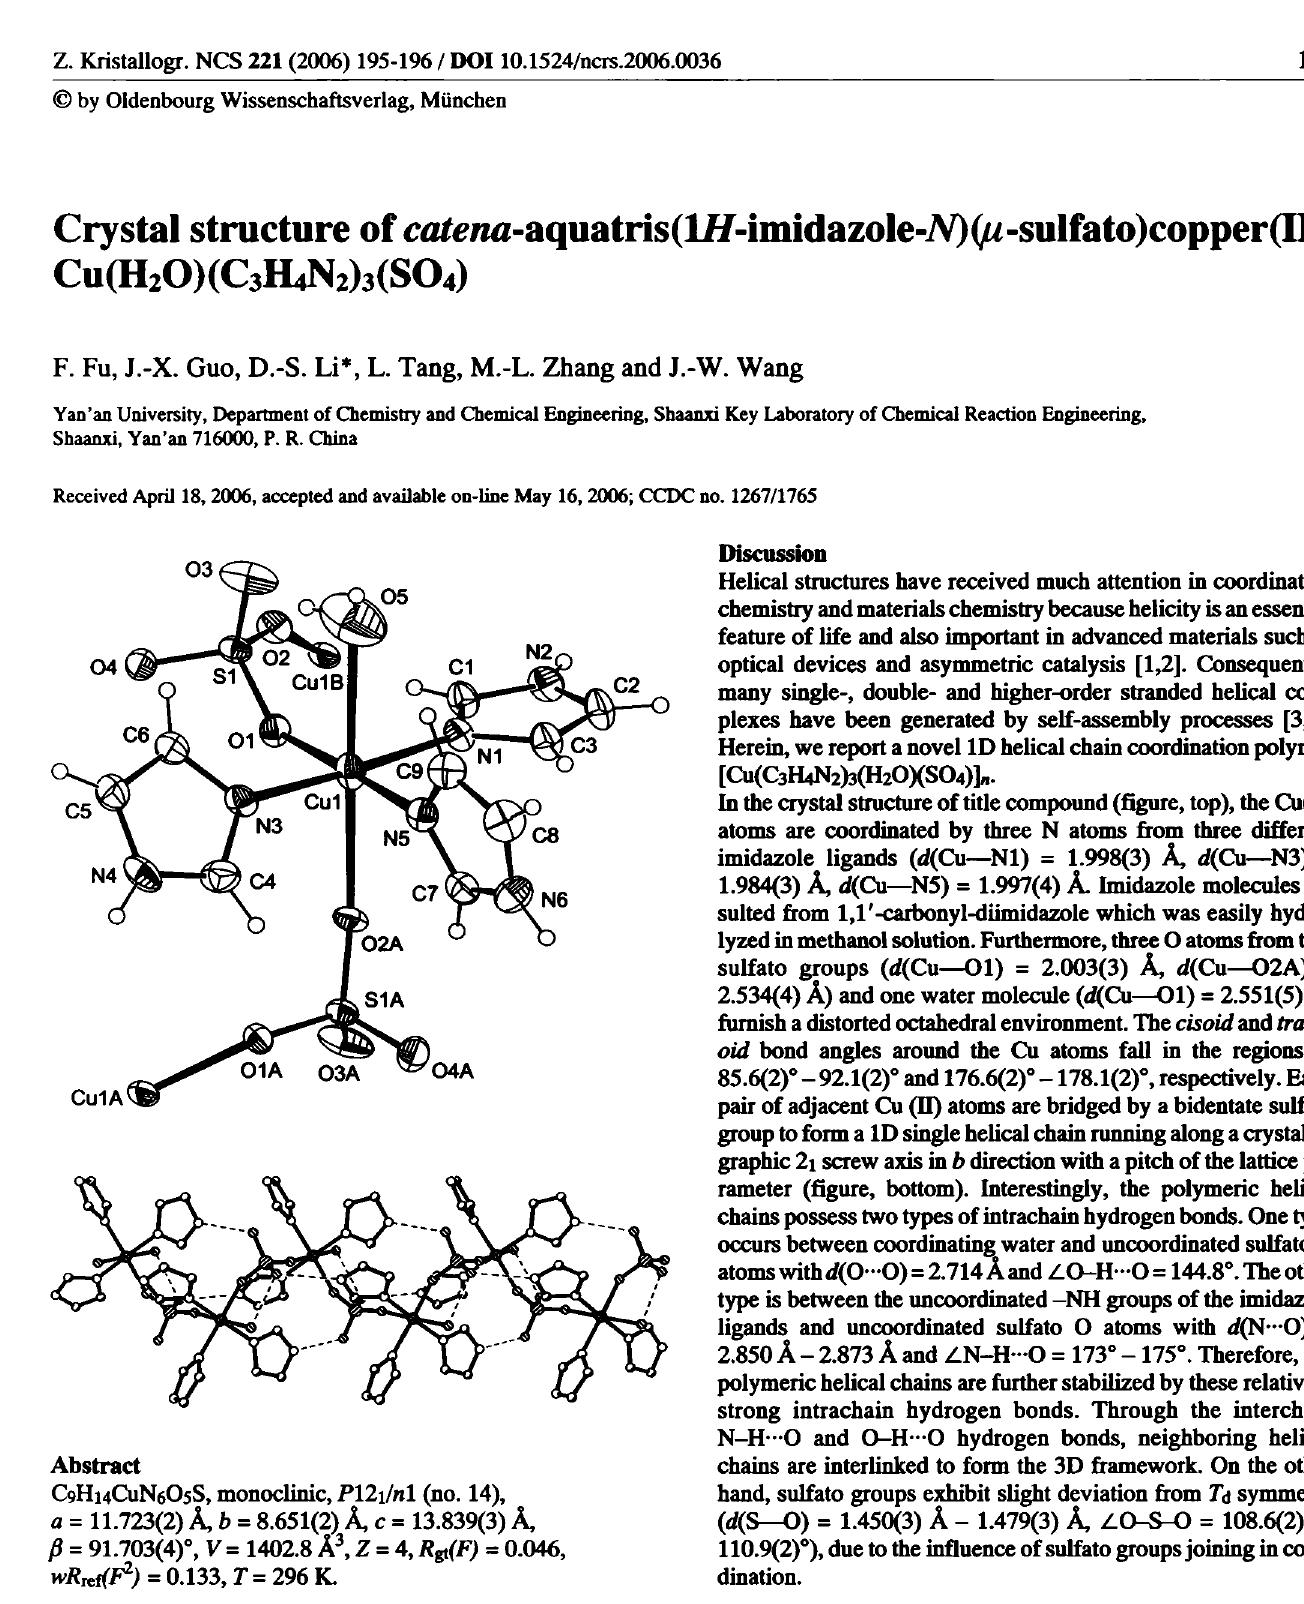
Table 1. Data collection and handling. Crystal: Wavelength: